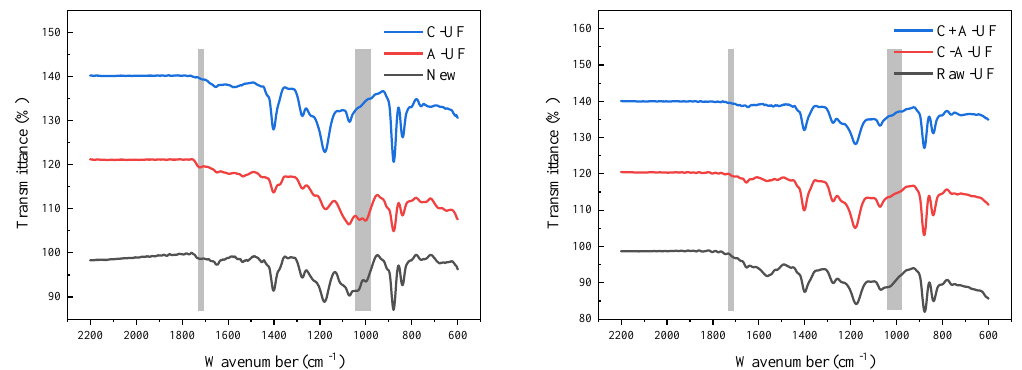
Figure 6. Attenuated total reflection flourier transformed infrared spectroscopy (ATR-FTIR) of the membrane at the end of the experimental period.